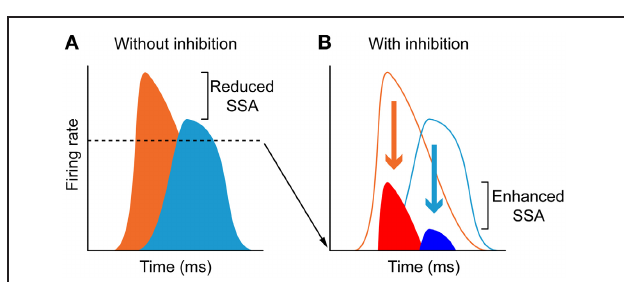
FIGURE 12 | The iceberg effect. (A) Schematic representation of a model of the iceberg effect indicating that in the absence of inhibition, neurons respond to deviants (orange) and standards (light blue) with high firing rates, and thus the deviant to standard ratio is small. (B) Inhibition reduces the responses to both deviants (red) and standards (dark blue) increasing the deviant to standard ratio and thus enhancing SSA. The dashed line in (A) , delimit the amount of activity (bottom area of the histograms) that decreases due to inhibition. Reproduced from Pérez-González et al.